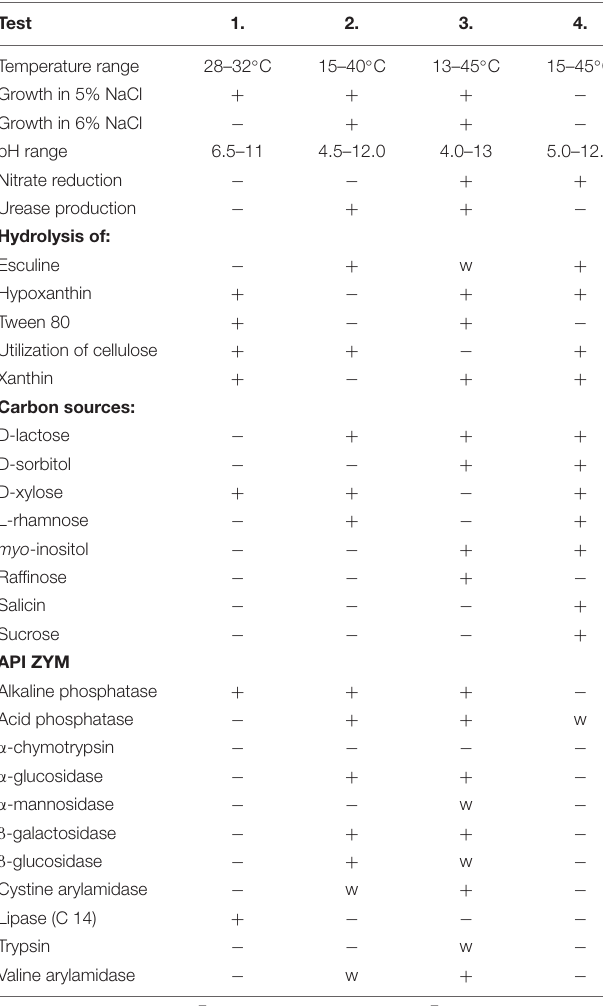
TABLE 2 | Cellular fatty acid composition (%) of strain P38-E01 T and closely related Streptomyces spp. Fatty acid